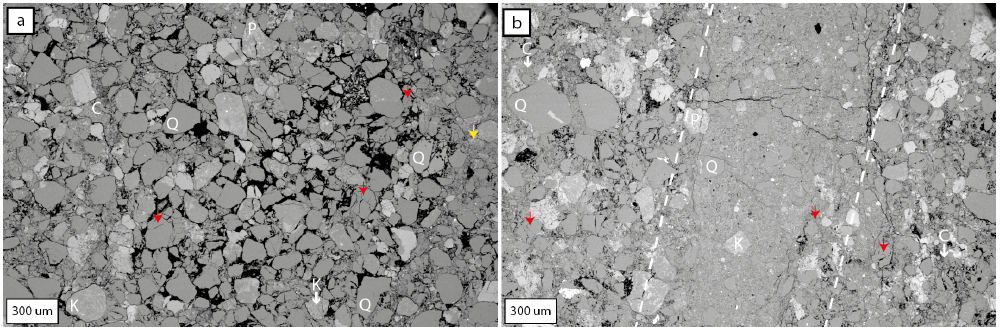
Figure 14. (a) BSE image of host rock located < 5cm from a D3 reverse-sense compactional shear band hosted within the damage zone of a reverse fault with an offset of < 1m. Pore space is clearly observed in the host rock. Within the host rock, regions of higher concentrations of fragmented grains are present (yellow arrow). This highlights the heterogeneity of the host rock. Microfractures are present within host-rock grains (examples are indicated by the red arrows). (b) BSE image of a deformation band associated with a D3 reverse-fault damage zone of a fault with < 1m offset. Dashed lines denote the boundaries to DBs. The band is characterised by reduced porosity and grain size compared with the host rock. The edge of the band is diffuse with a gradual increase in porosity into the host rock. The pore space within the band is filled with fine-grained fragments of deformed host-rock grains. Microfractures are observed within the preserved host-rock grains within the DB (red arrows). A potentially late extension fracture cuts across the deformation band and does not appear to propagate into the host rock. Q denotes quartz, C denotes zones of clay-sized particles, K denotes potassium feldspar, and P denotes plagioclase.